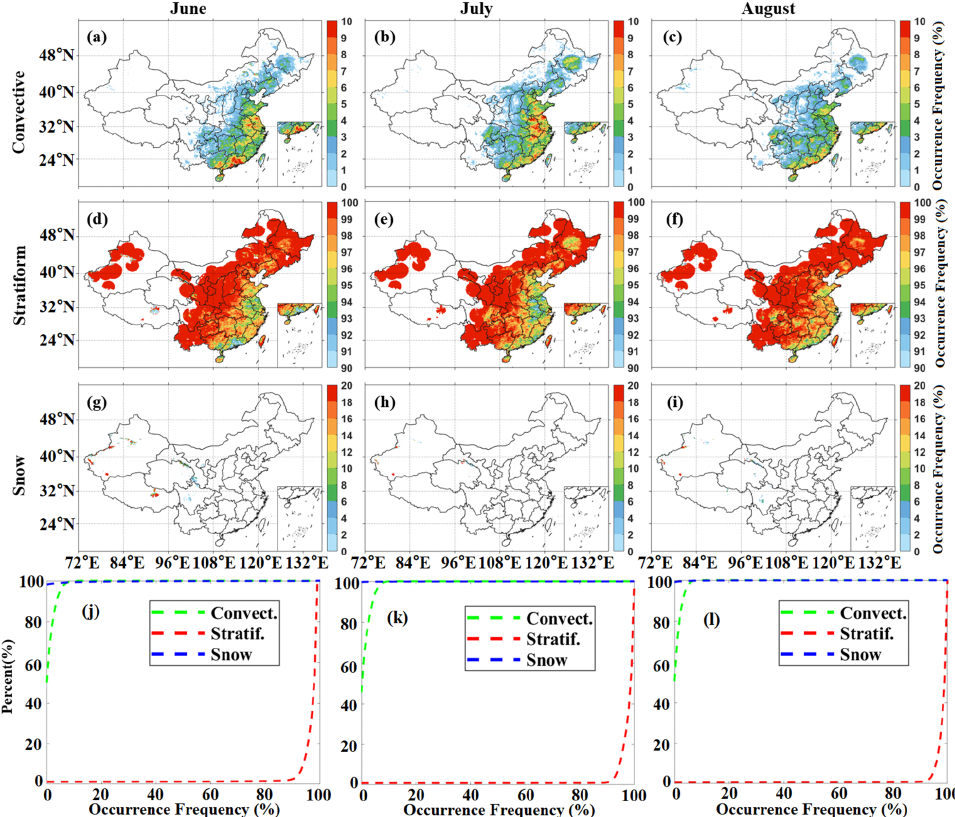
Figure 5. ( a – i ) Spatial distribution of monthly precipitation frequency (%) for each precipitation type over China in three months. ( j – l ) Cumulative probability distribution of each precipitation from June to August.